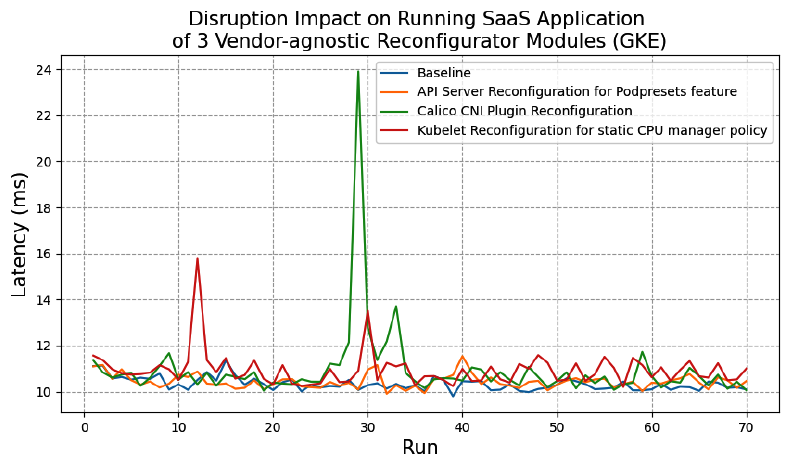
Figure 11. Disruption impact of the three Reconfigurator modules on SaaS